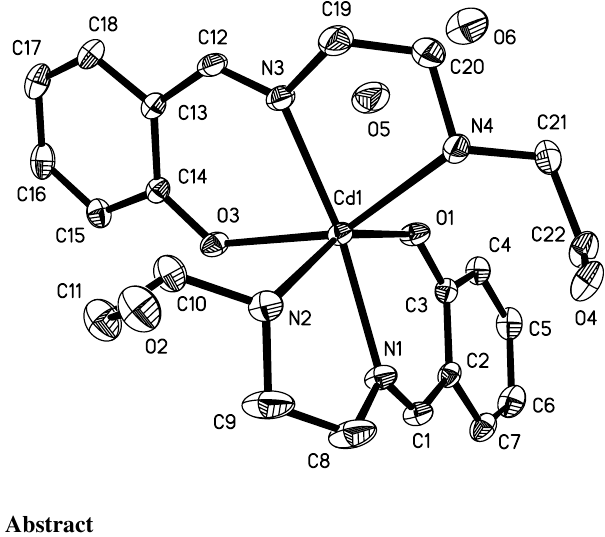
Table 1. Data collection and handling.